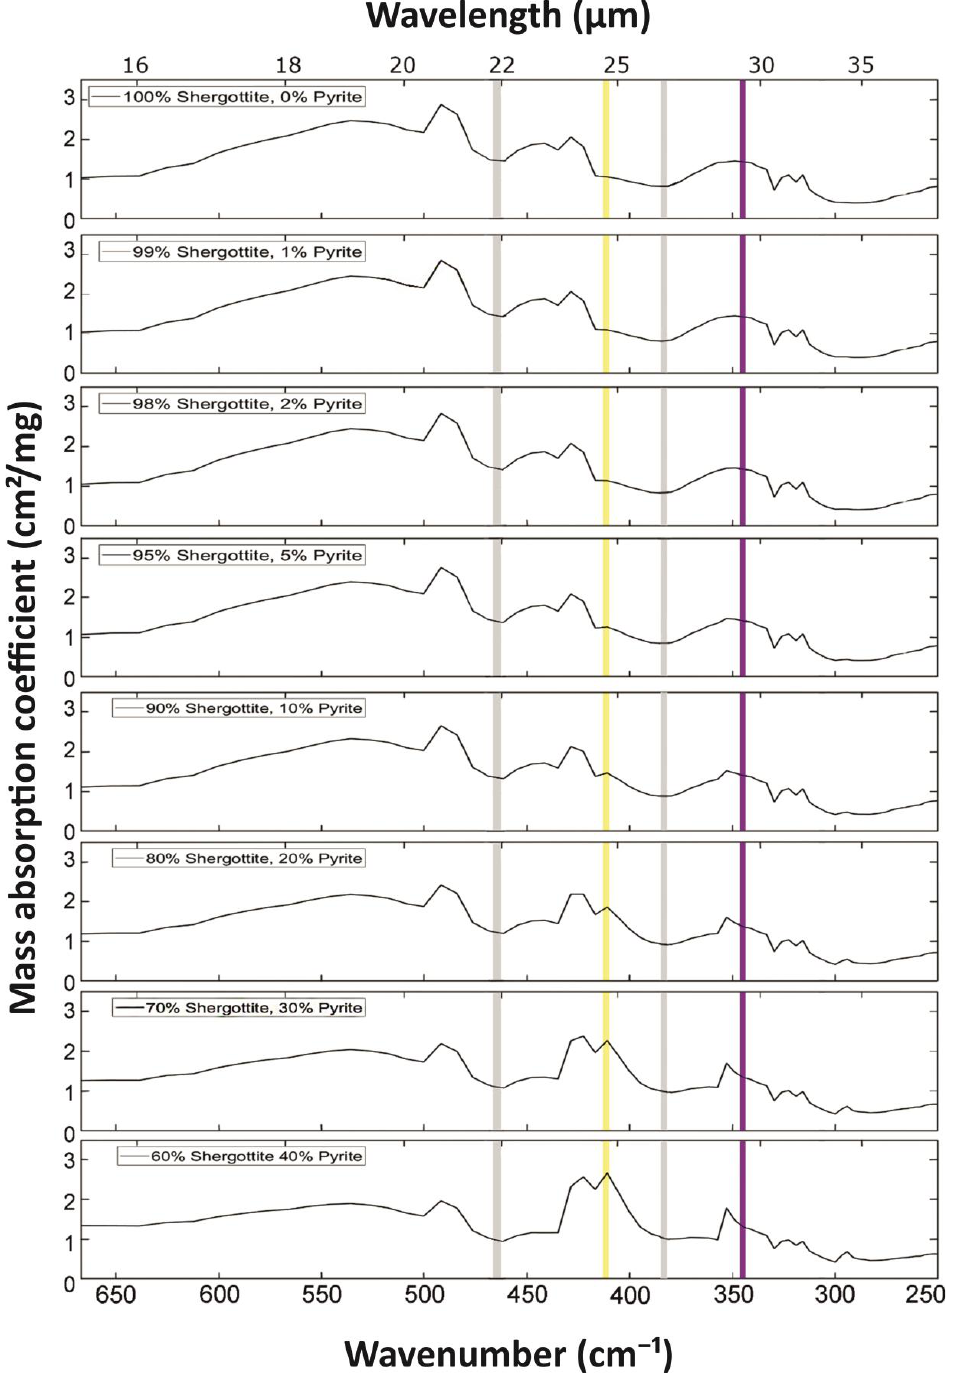
Figure 7. Mass absorption coefficients that we simulated for surfaces composed of various pro- portions of pyrite and olivine-phyric shergottites. The composition of olivine-phyric shergottites was the same as in the text of Section 3 but normalized from 92% to 100%. The input spectra were derived from Figure 5. The spectral ranges of four of six detectors are marked with rectan- gles: yellow (409–414 cm − 1 = 24.15 − 24.45 µ m: pyrite), grey (381–385 cm − 1 = 25.95 − 26.25 µ m and 462–468 cm − 1 = 21.35 − 21.65 µ m: reference bands), and purple (343–347 cm − 1 = 28.85 − 29.15 µ m: clinopyroxene). There is partial interference between pyrite and the secondary clinopyroxene peak on the right (at ~421 cm − 1 = 23.8 µ m, cf. Figure 5), becoming significant when pyrite is <10%. The signal from this interference was taken out using Equation (1). The mineral mixtures were calculated using the Matlab script in Supplementary Material